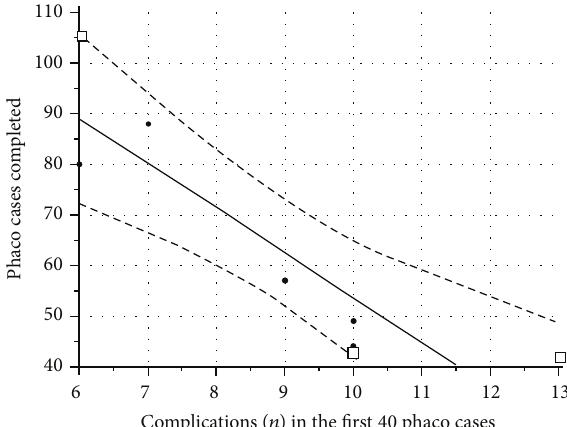
Figure 1: Incidence of posterior capsular rupture (PCR) or zonular dehiscence (ZD) with vitreous loss in each study group, dividing cases into decades as they were chronically performed by residents, referring to their first forty phacoemulsification procedures.